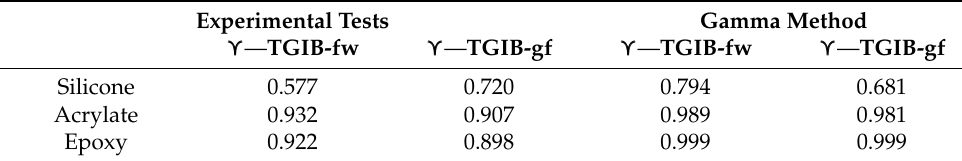
Table 13. Comparison of results of measurements for